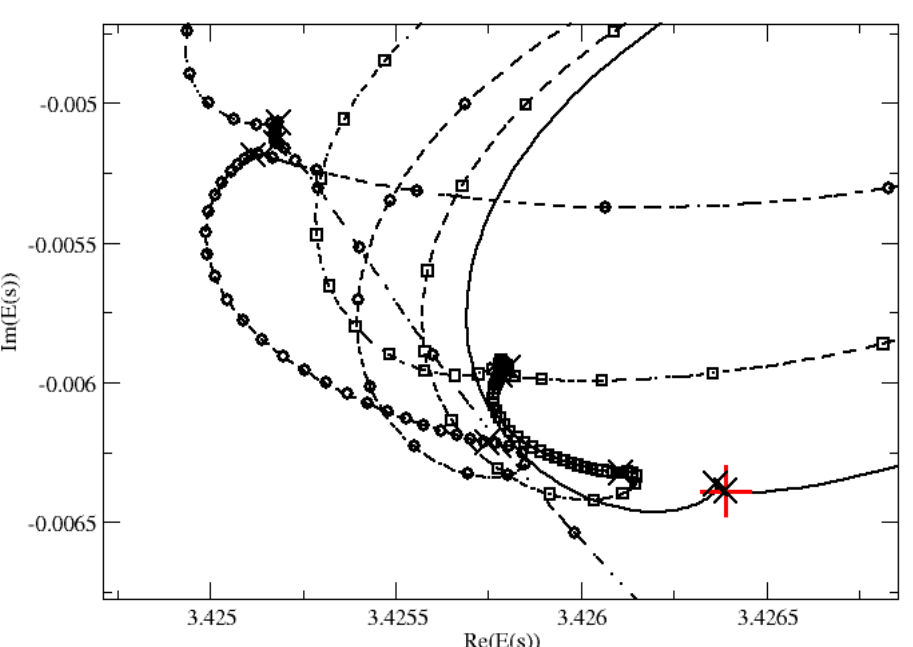
Figure 3. Trajectories (with z 0 = 0) in the case ζ = λ = 0.01 for the problem I (solid line), problem II (dashed lines), and problem III (dash-dotted lines). Calculations were carried out for various values of N, i.e., ○ —N = 100, □—N = 600. Signs + and x indicate the position of the resonance and optimal point, respectively. Data are presented in a.u.